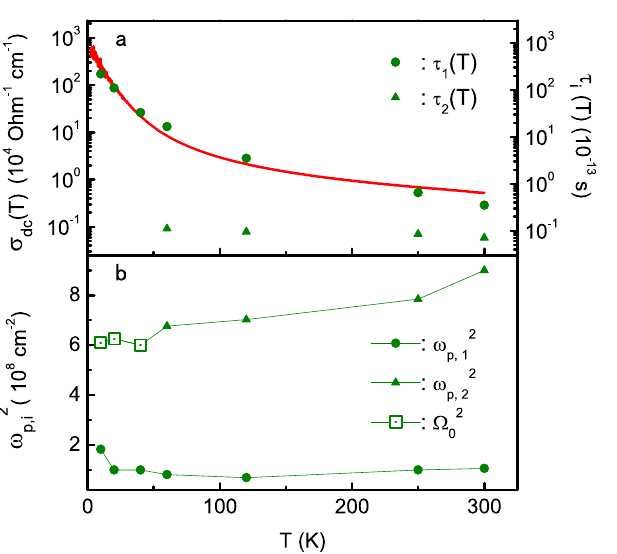
Figure 6. Fitting parameters for the two low-frequency components in the b -axis optical spectra. ( a ) Temperature dependence of τ i and its comparison with the b -axis dc conductivity (solid line). ( b ) Temperature ,2 in the ferromagnetic phase and its comparison with Ω 02 in the dependence of the corresponding ω p i helimagnetic